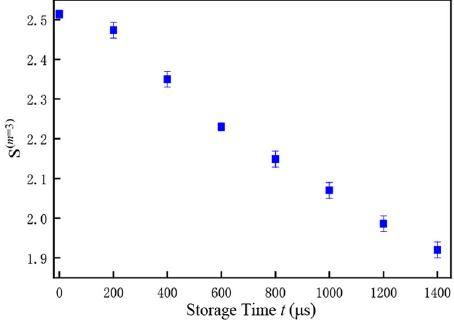
Fig. 3 Bell parameters S ð m Þ as a function of t for χ ¼ 1%. Blue squares are experimental data of the decay of the parameter S ð m ¼ 3 Þ for various storage times t . The error bars represent the standard deviation of measured values.